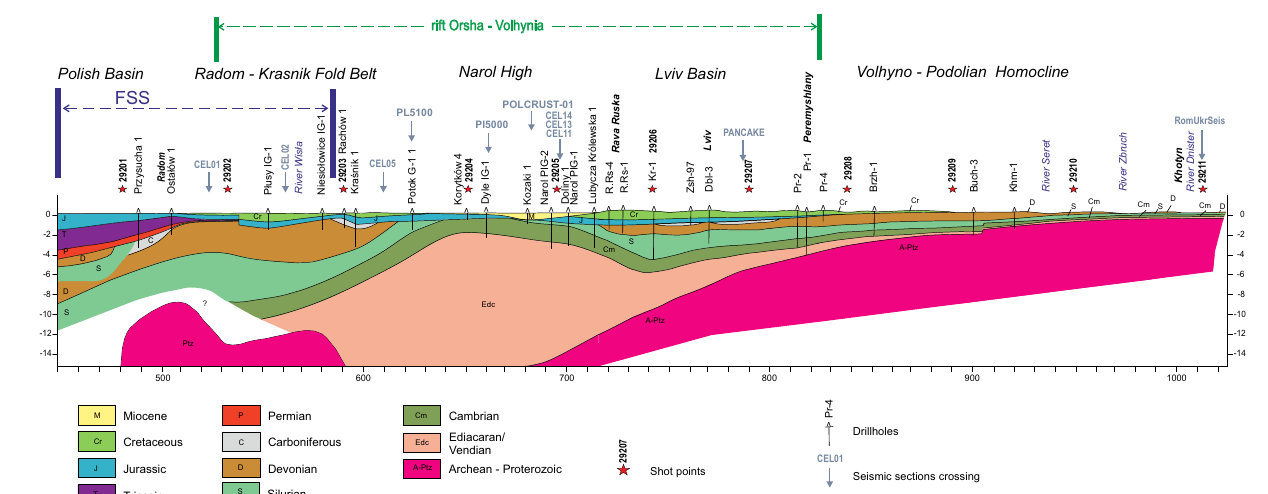
Figure 11. Geological cross-section along the TTZ-South seismic profile. The section is much simpli- fied, with no faults shown, 5 times vertically exaggerated and partly hypothetical, combining drillhole results for shallow levels with reflection seismic data of the PolandSPAN TM project (as presented by Mikołajczak et al. [16] and Mikołajczak [26]) and wide-angle reflection/refraction seismic models from this and previous papers for deeper levels, and data from other sources (e.g., [42,111]). Faults are completely omitted as they mostly cannot be unambiguously interpreted from the available data, particularly when the profile stretches along or at a very low angle to the trend of the major structures. Along-strike projections of the range of several predicted locations for the Fennoscandia—Sarmatia suture (FSS, after [23,31,43], taking into account data from [24,25] and of the Orsha—Volhynia rift basin system (after [23,43]) from the East European craton are also